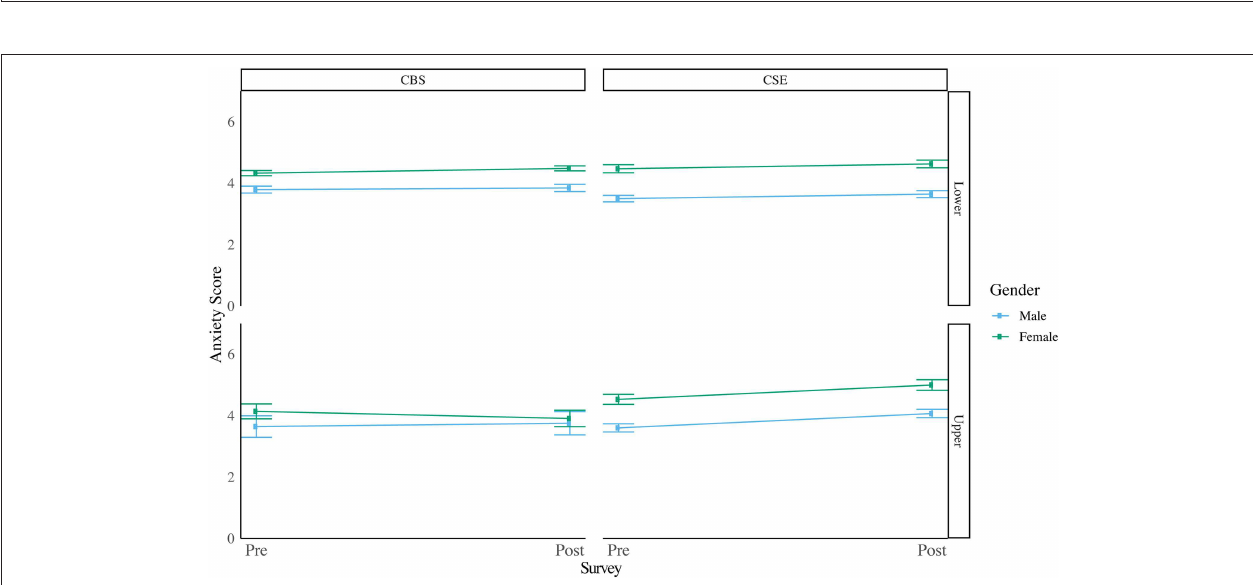
FIGURE 5 | Change in test anxiety over the course of the semester for students in CBS and CSE for women (green) and men (blue) in lower division courses (Top) and upper division courses (Bottom) . The survey was administered at the beginning of the semester (pre-survey) and at the end of the semester (post-survey; i.e., after students completed the last in-class test, but before their final exam). On average, women (green) reported higher levels of test anxiety than men (blue) in lower division courses in the College of Biological Sciences (CBS) and in both upper and lower divisions in the College of Science and Engineering (CSE). In upper division CSE, average test anxiety significantly increased for all students over the course of the